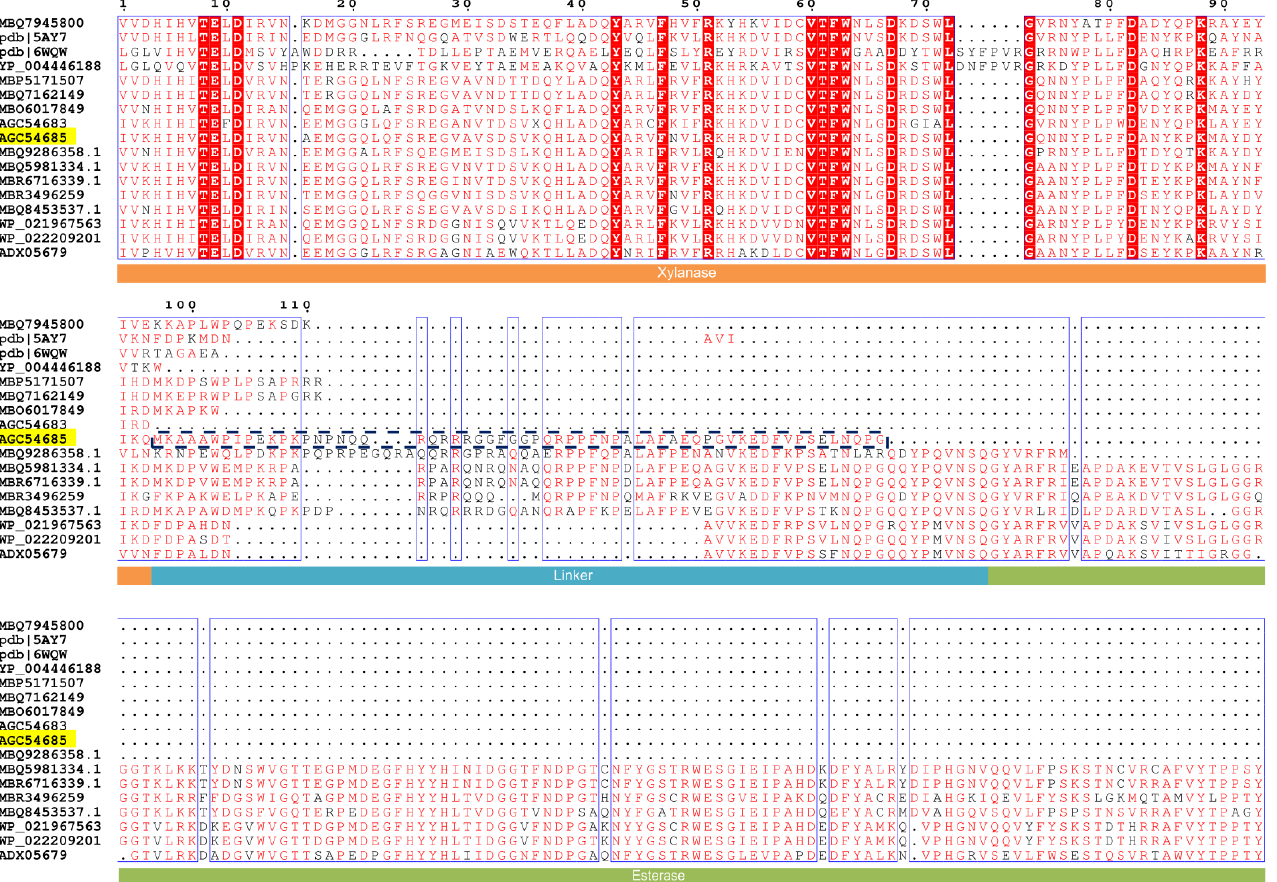
Figure 2. The amino acid sequence alignment regarding XynA and C-terminal region C60 with the other homologous sequences. The sequences contain the xylanases from Bacteroidales bacterium (MBQ7945800, MBP5171507, MBQ7162149, and MBQ9286358.1), Aegilops speltoides sub sp. speltoides (pdb|5AY7), Thermobacillus (pdb|6WQW), Haliscomenobacter hydrossis (YP_004446188), Prevotella sp. (MBQ5981334.1, MBR6716339.1, MBR3496259, and MBQ8453537.1), Bacteroides intestinalis (WP_021967563), and Bacteroides cellulosilyticus (WP_022209201). The same amino acids are marked in dark red and red. The bottom orange rectangle is the xylanase domain, the blue rectangle is the linker region, and the green rectangle is the esterase domain. The dark blue dashed box marked in the sequence is C60.